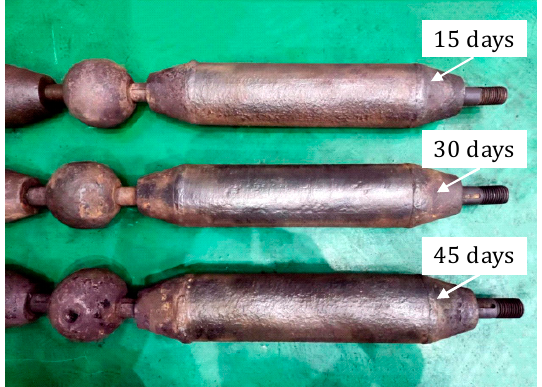
Figure 6. Corroded bolt-sphere joints with members. Table 5. Results of accelerated corrosion of the bolt-sphere joints with members